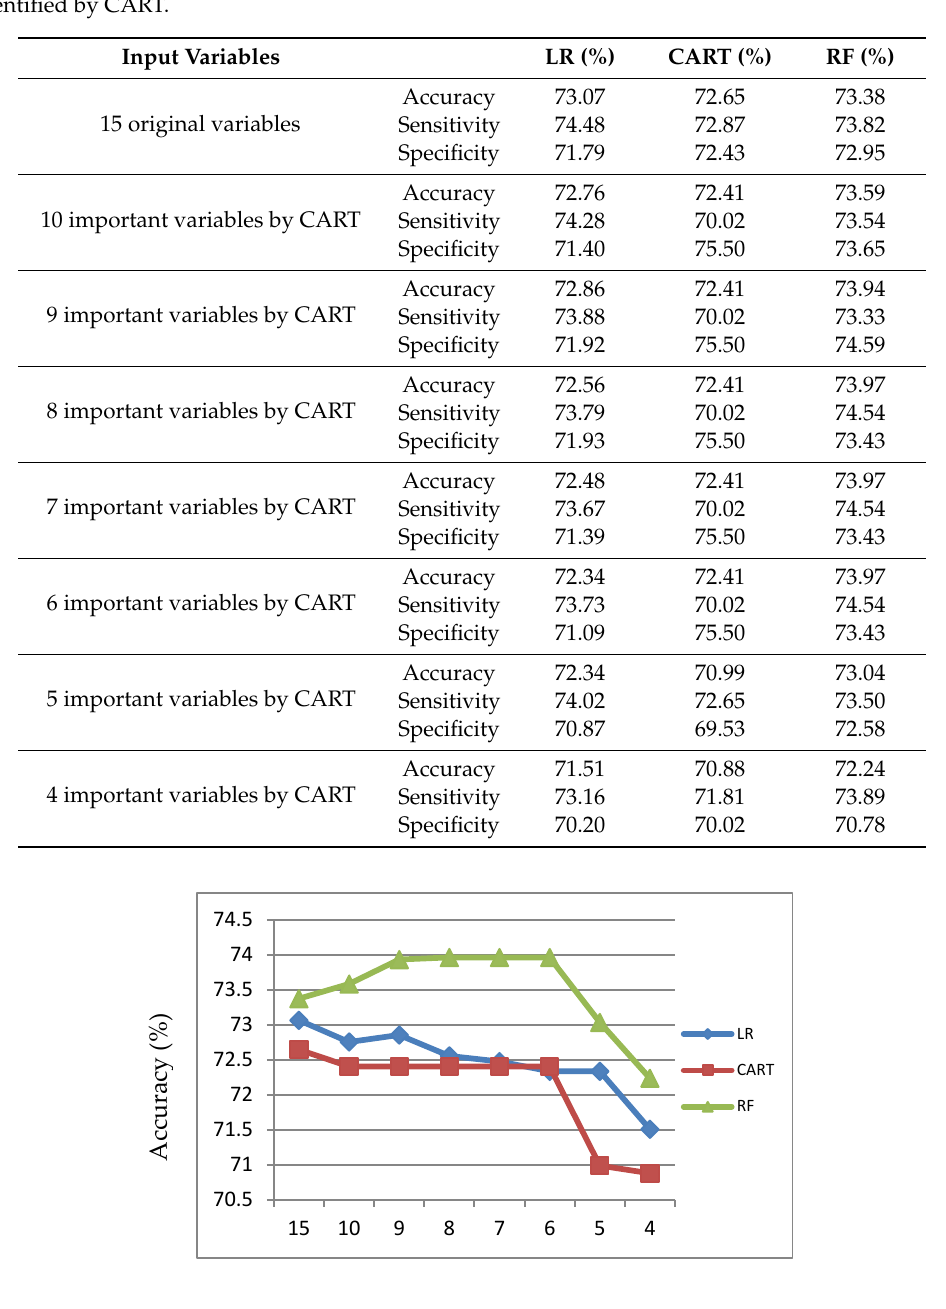
Figure 5. Sensitivity of LR, CART and RF with input of important variables identified by CART. Figure 6. Specificity of LR, CART and RF with input of important variables identified by CART.